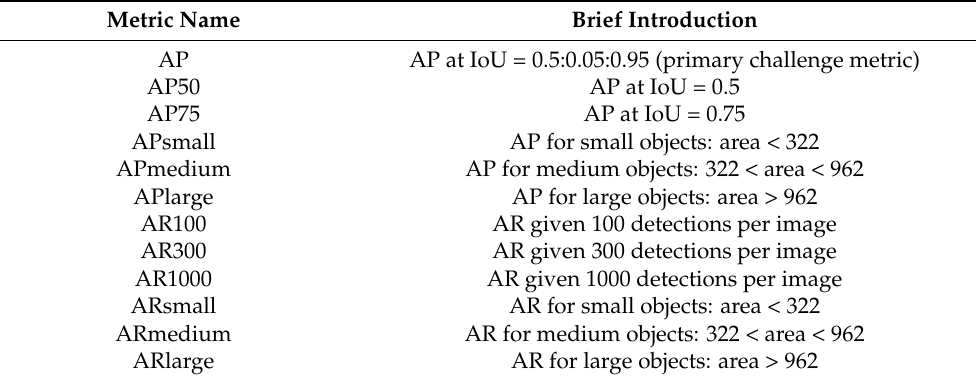
Table 3. COCO Evaluation